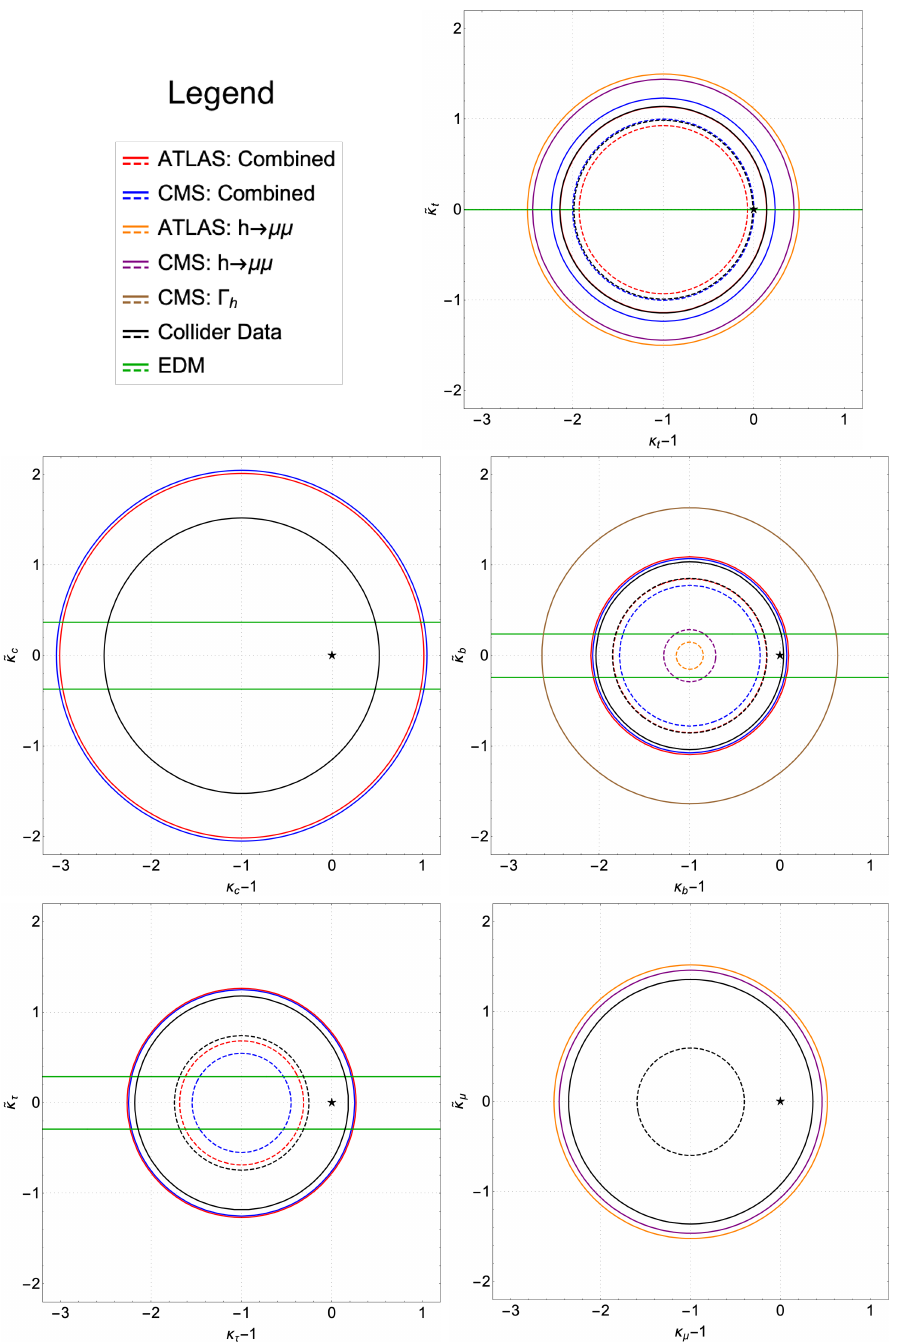
Figure 1 . Bounds in the (( κ ψ − 1) , ˜ κ ψ ) -plane, with NP only in the single ψψh coupling. These limits are derived from χ 2 fits to the signal strengths and the Higgs total decay width reported in refs. [66–69] (red lines) and from electron EDM constraints from the ACME II collaboration [62]. Continuous (dashed) lines refer to the upper (lower) bounds. The SM case ( κ ψ − 1 = ˜ κ ψ = 0 ) is represented with a